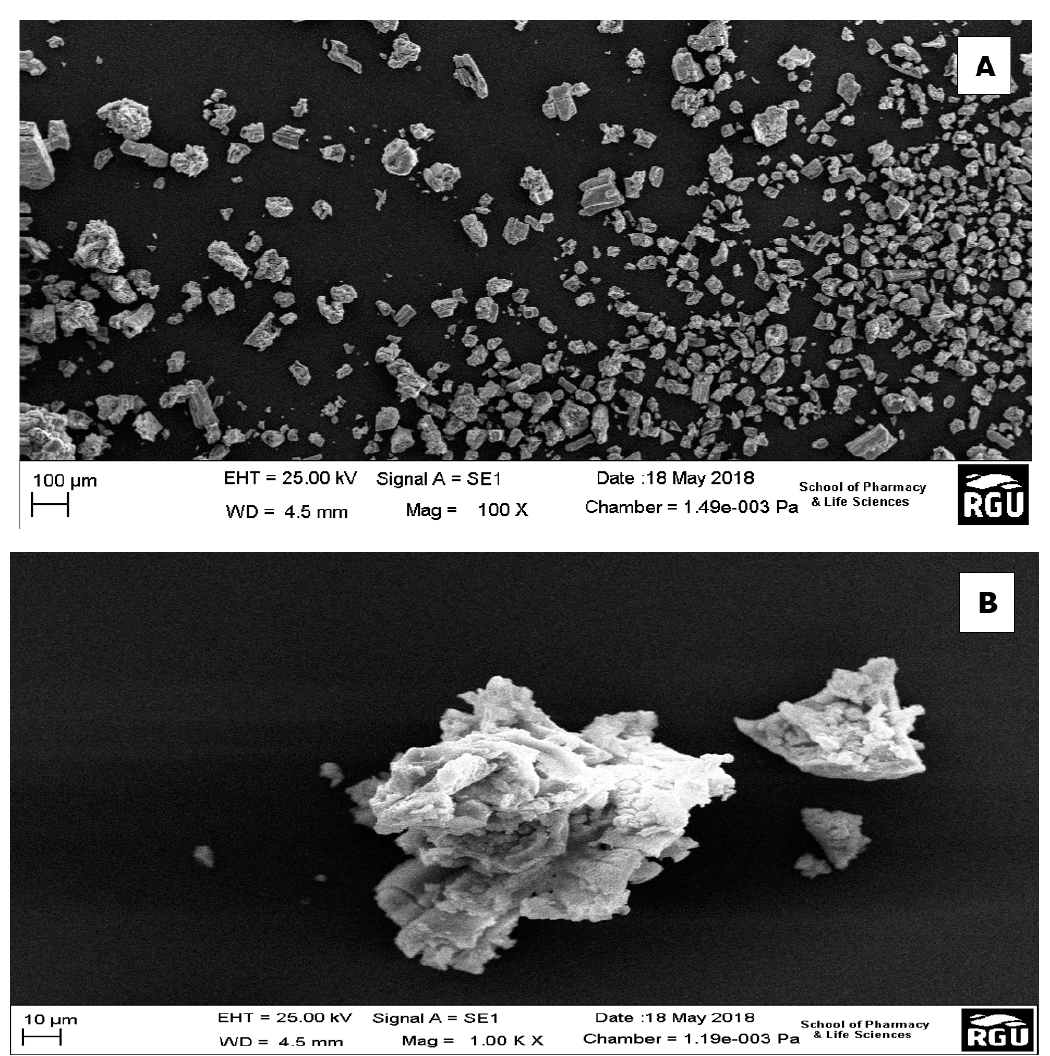
Figure 2. ( a ) SEM image showing the morphology of ZrO 2 nanoparticles; ( b ) One of the aggregates of the ZrO 2 nanoparticles.